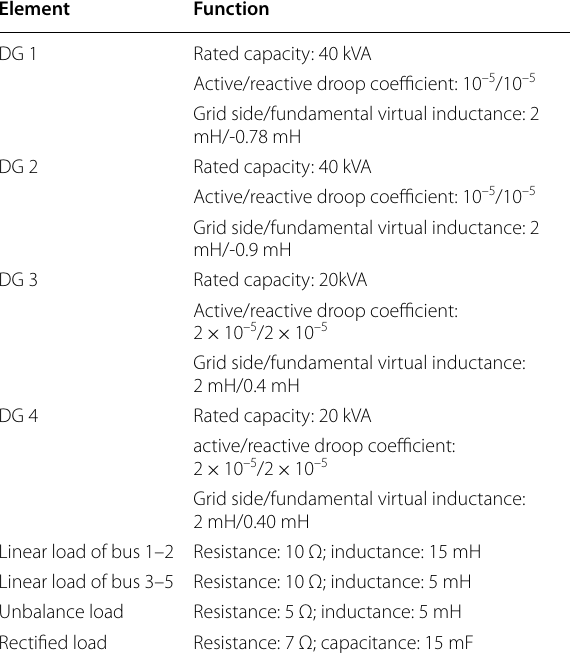
Table 3 Simulation parameters